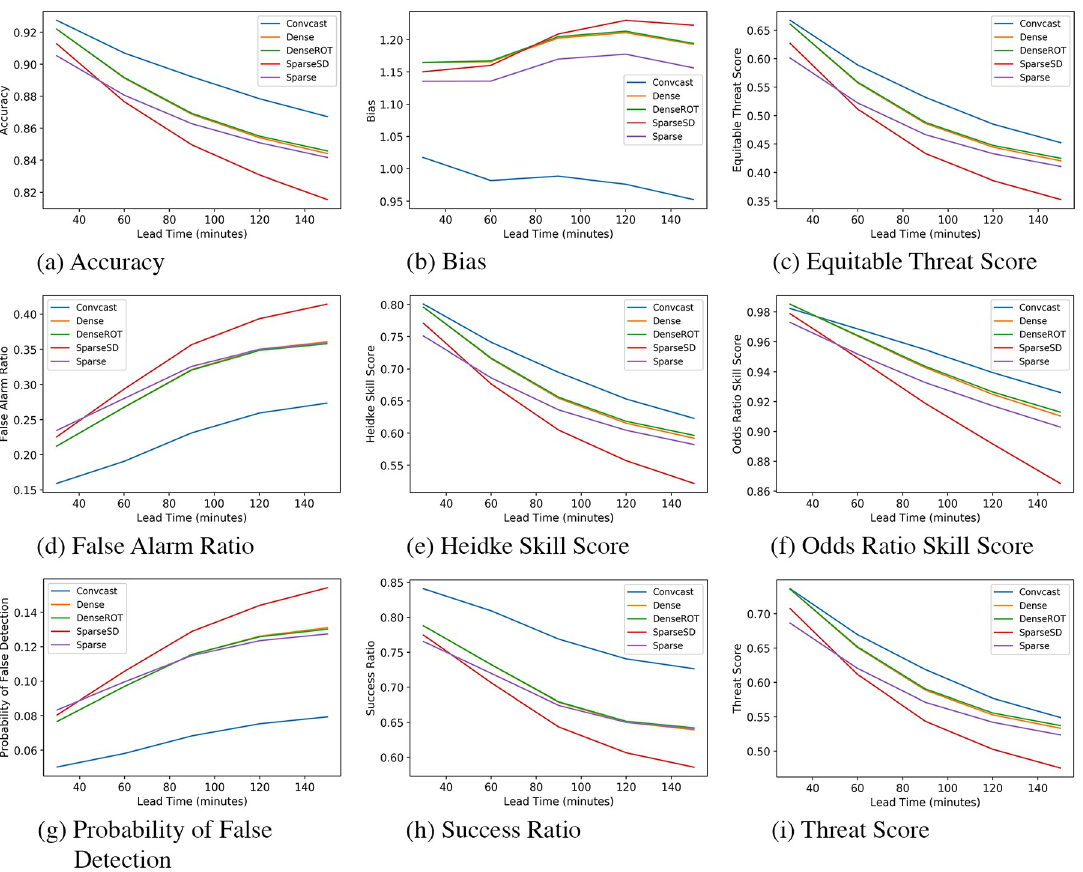
Fig 5. Variation of dichotomous accuracy scores with